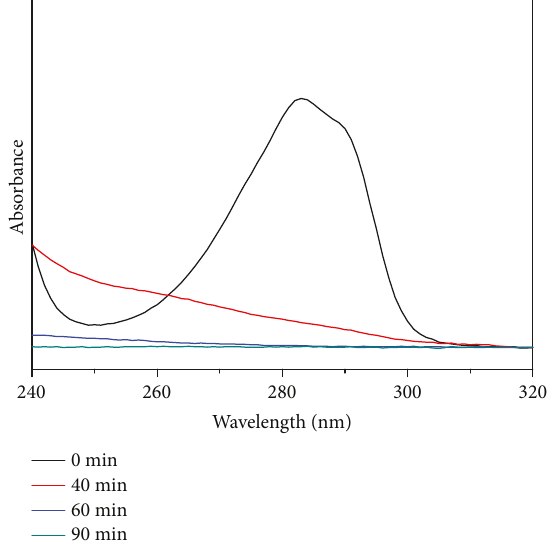
Figure 13: Full-scan UV – Vis absorption spectrums of 2,4-DCP solutions after treatments by T-H-400 for 0min, 40min, 60 min, and 90